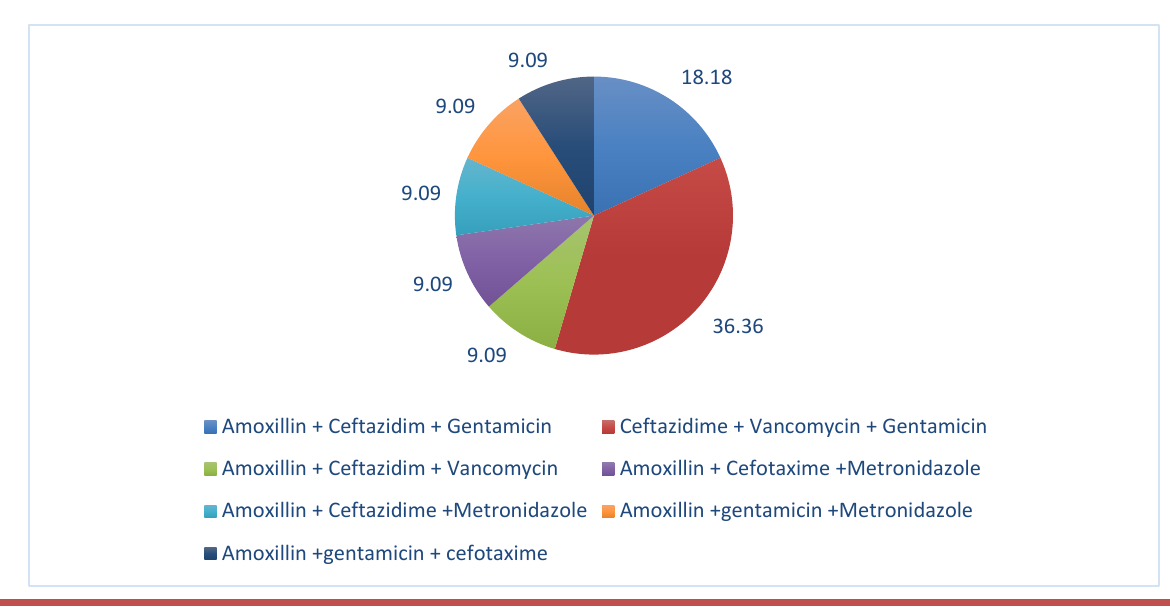
Figure 8: Double antibiotics prescribed in NNCU (Total